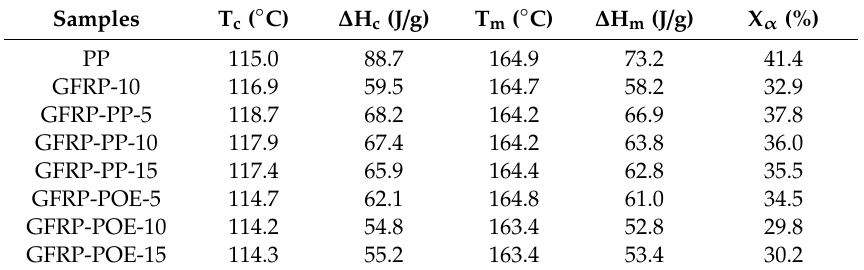
Figure 4. Effects of different ratio of PP-g-MAH on the crystal behavior and melting behavior of GFRP: ( a ) DSC curves of crystallization behavior; ( b ) DSC curves of melting behavior. Table 2. Crystallization and melting characteristics of GFRP with di ff erent compatibilizers.